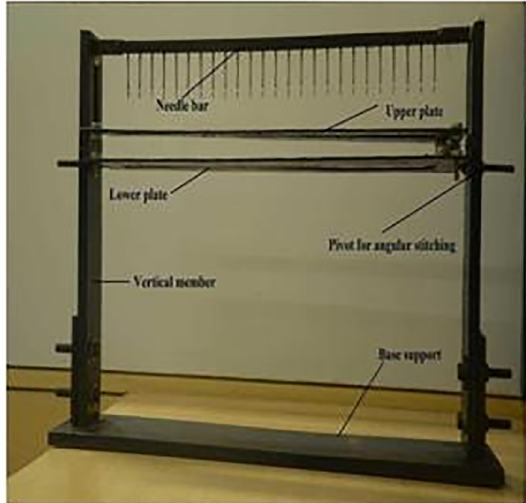
Figure 4. Front View of the Stitching